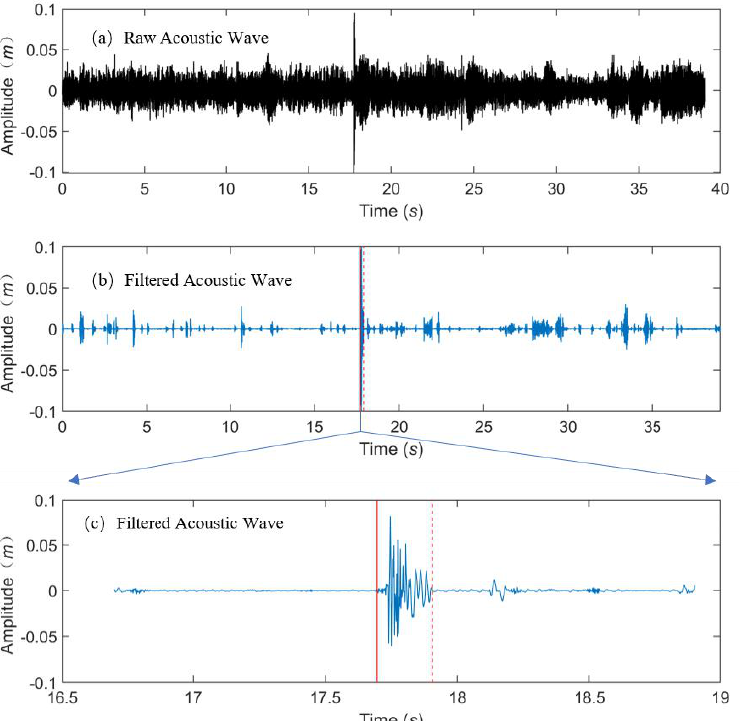
Figure 2. An example of acoustic signal processing: ( a ) A recorded raw acoustic wave profile; ( b ) An acoustic wave after applying spectral subtraction noise reduction; ( c ) A close − up of the acoustic wave after applying noise reduction and endpoint detection.